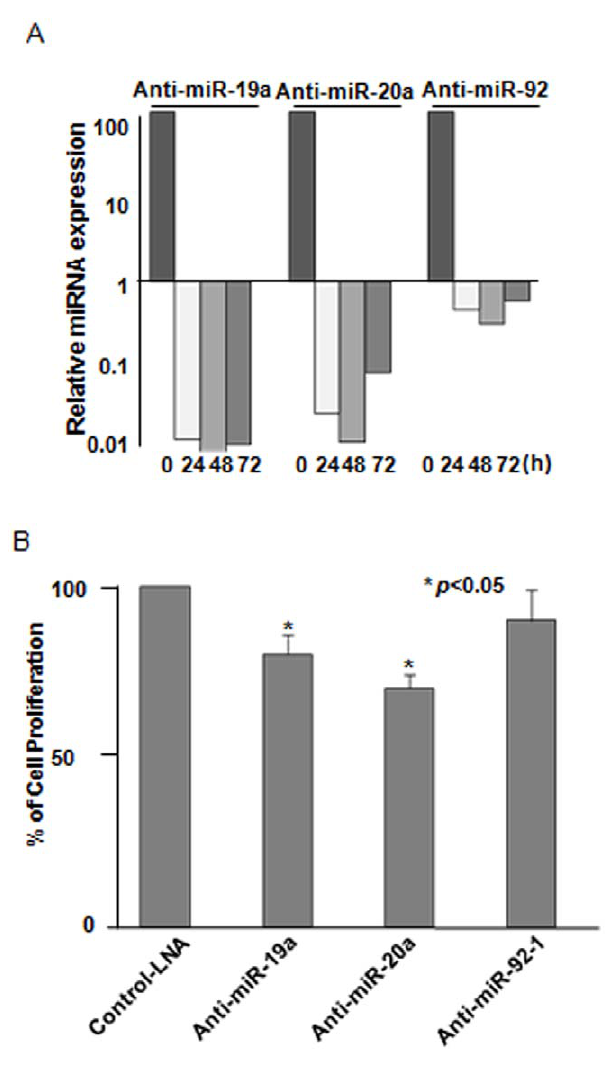
Figure 2. Effects of the anti-miR-LNA on MCF-7 cells. (A) The repression of miRNAs after the treatment of MCF-7 cells with the anti- miR-LNA. MCF-7 cells were transfected with an anti-miR-19a, anti-miR- 20a, anti-miR-92-1 or control LNA. Significant repression of miR-19a (left), miR-20a (middle) and miR-92-1 expression (right) by the anti- miRNA-LNAs was observed from 24 to 72 hours after transfection. (B) Cell viability after the treatment of MCF-7 cells with the anti-miR-LNA. MCF-7cells were transfected with anti-miR-19a, anti-miR-20a, anti-miR- 92 LNA and control LNA. Cell viability was determined using a WST-1 assay at 96 hours after transfection. The % cell proliferation was calculated by comparing the viability of cells treated with the anti-miR- LNAs compared to those treated with control